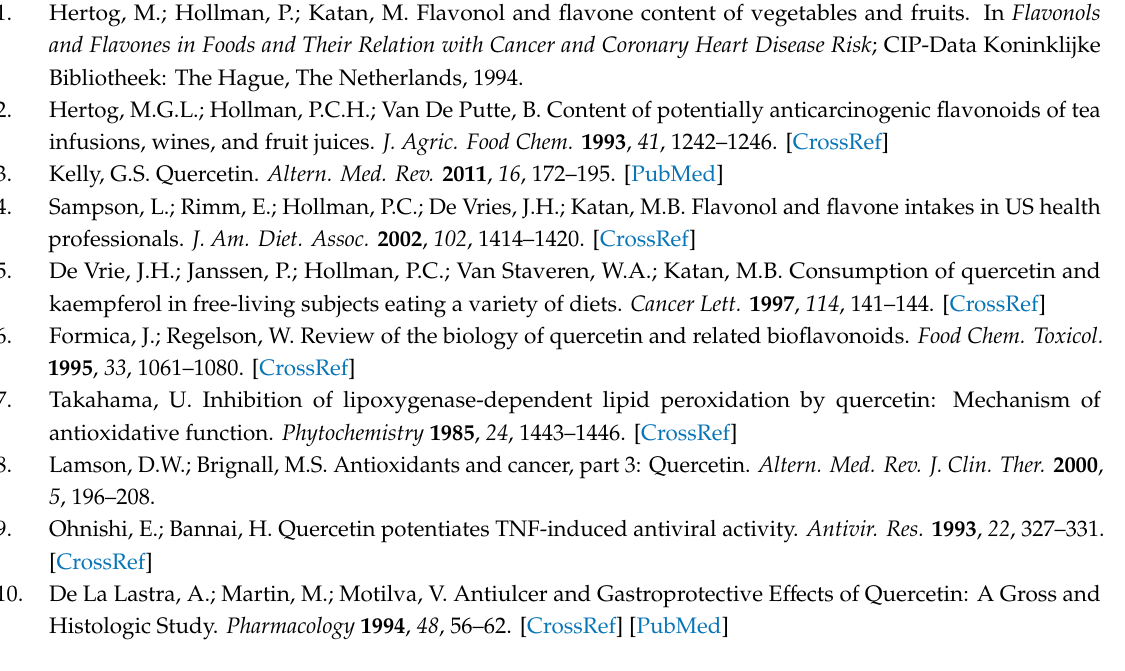
Figure S1: mRNA expression levels of BCRP in HeLa, Caco-2, MCF-7 and SW620 cell lines using RT-PCR, Figure S2: E ff ect of 100 µ M quercetin alone on the cell viability of HeLa